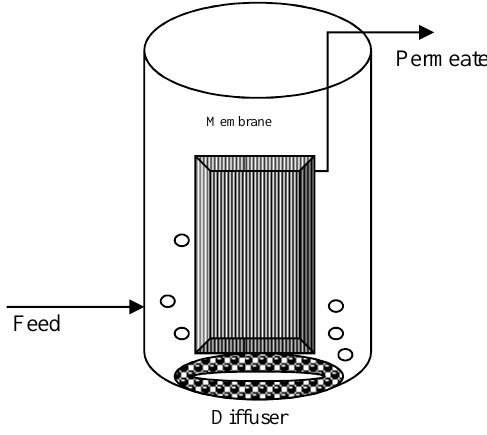
Figure 1. Details of membrane module used in this